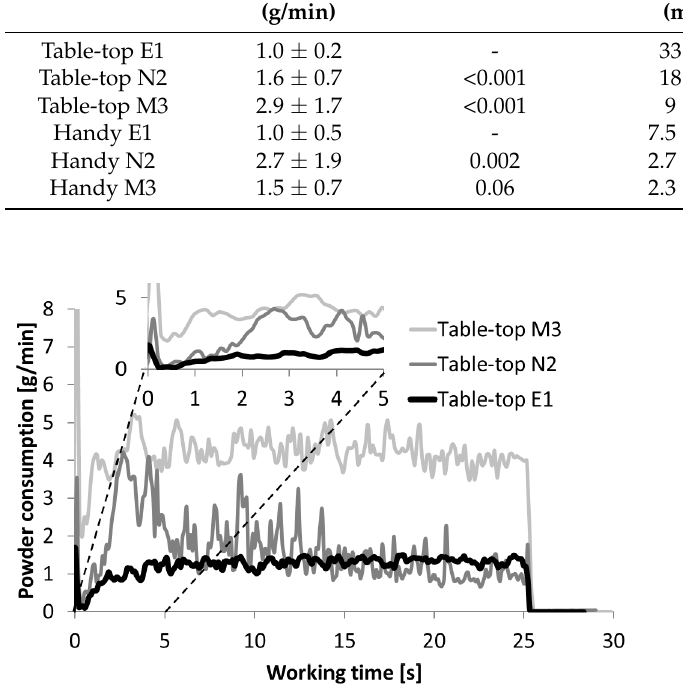
Figure 4. Table-top powder consumption during one pedal press of 25 s, and an enlarged view of the first 5 s. first 5